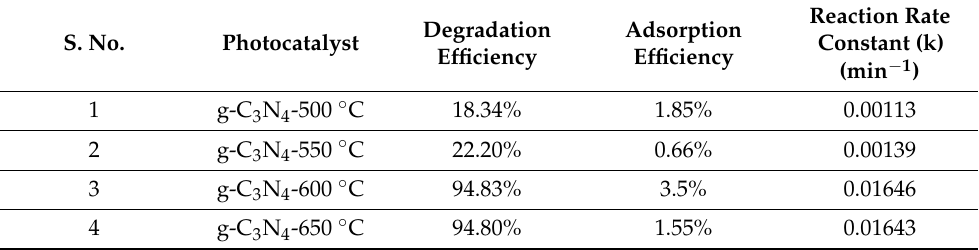
Table 2. Photodegradation efficiency and reaction rate constant of all prepared g-C 3 N 4 samples at different calcination